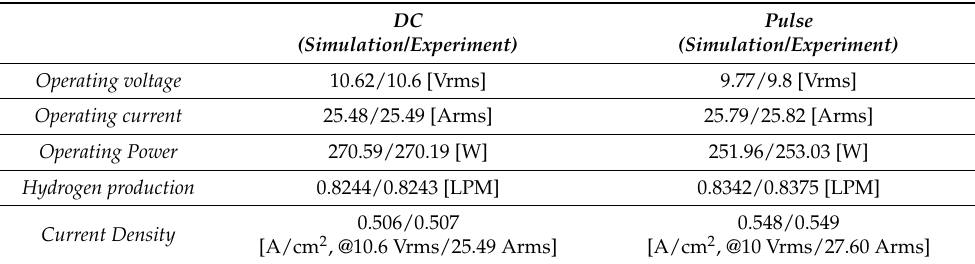
Figure 15. Stack voltage and current pulse patterns applied to the experiment. Table 3. A PEM electrolysis experimental result